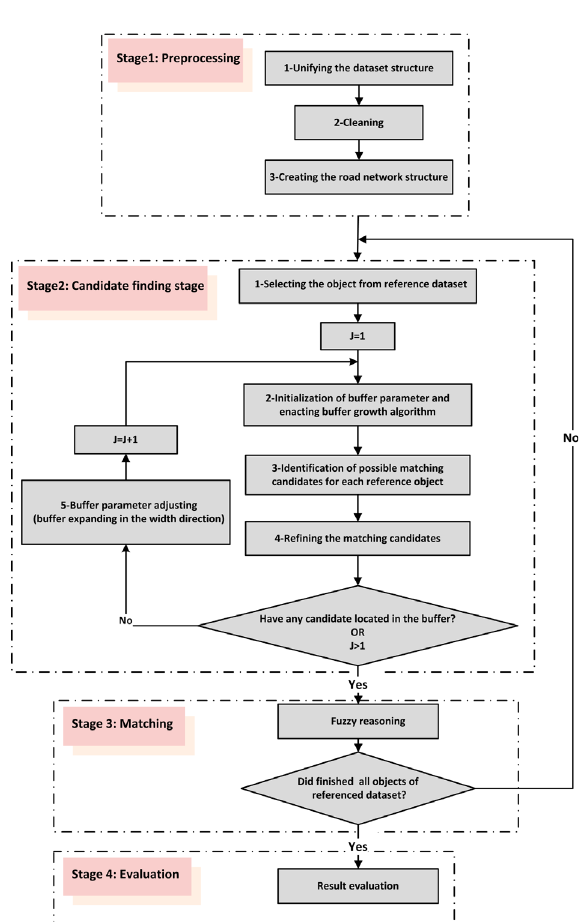
Fig. 6. The details of proposed